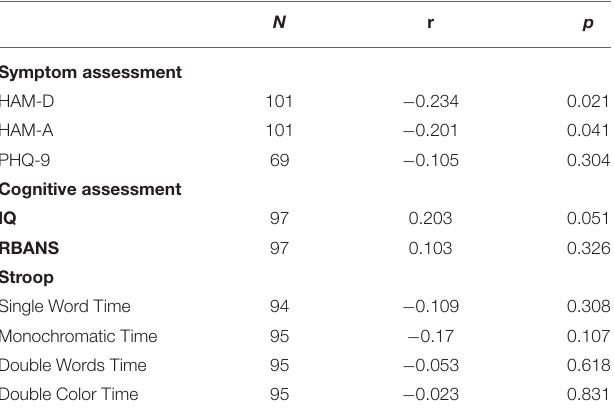
TABLE 3 | Associations between plasma D β H activity and clinical or cognitive assessments in patients with